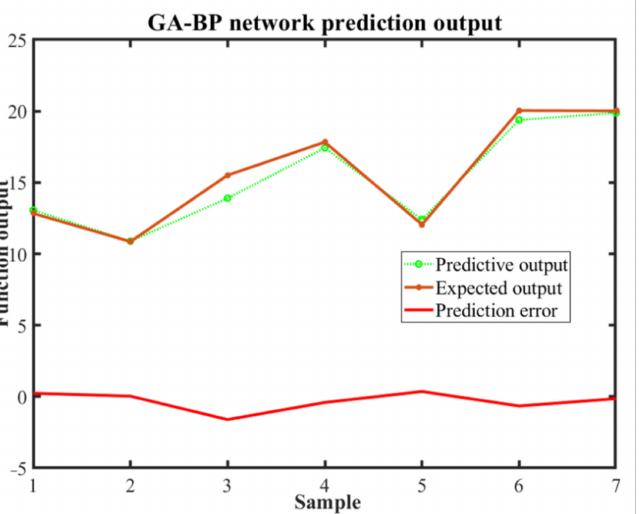
Figure 19. Comparison and error diagram of GA-BP neural network predictive value and expected